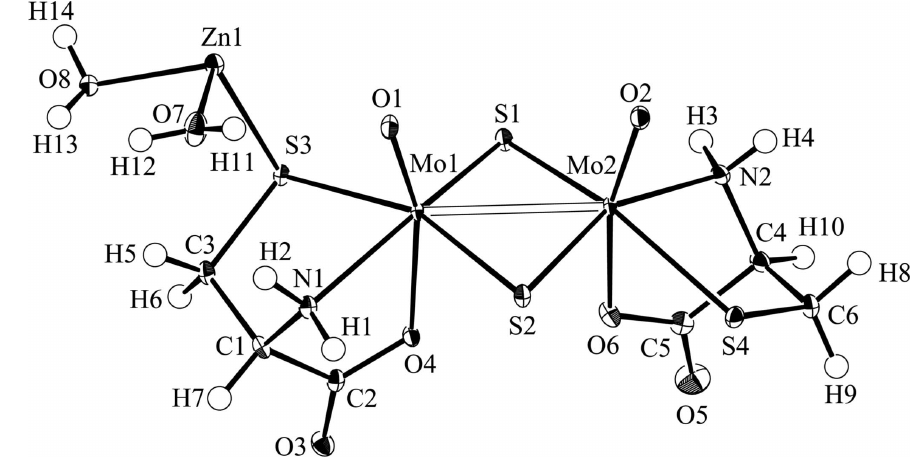
Figure 1 The asymmetric unit of I with atom labels and 50% probability displacement ellipsoids for non-H atoms.